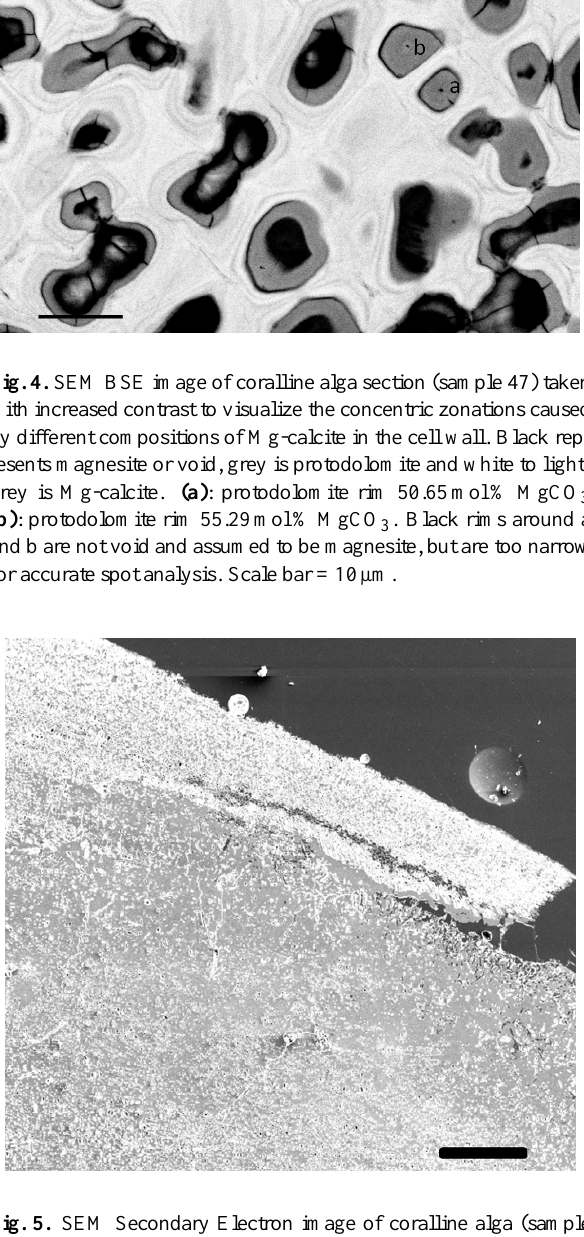
Fig. 5. SEM Secondary Electron image of coralline alga (sample 47), showing varying amounts of mineralisation in the top pho- tosynthetically active layer and underlying crust. White indicates space void of mineral in-fill, grey is mineralised cell walls and in- filled cells, black is epoxy resin. Whilst the top layer clearly has less in-fill, it does contain some magnesite cell in-fill close to surface. Protodolomite is noticeably least present in the top layer compared to basal layers. Scale bar = 200µm.